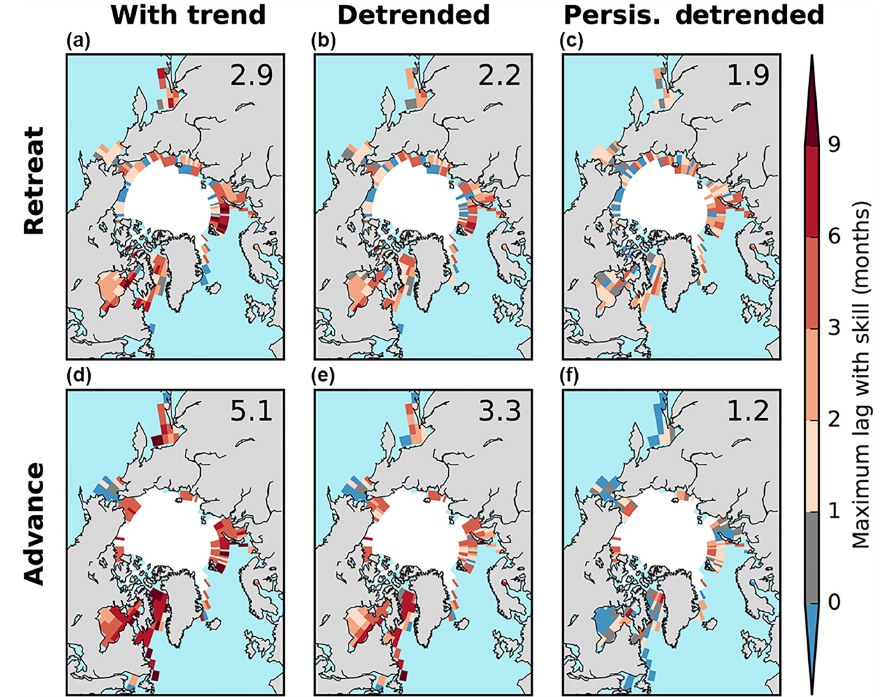
Figure 15. Maximum lead time at which CanSIPS skillfully predicts retreat and advance dates (defined as the calendar date at which sea ice concentration first drops below or exceeds 50%) for total anomalies (first column), detrended anomalies (second column), and a detrended persistence forecast based on persisting the observed initial sea ice concentration anomaly. The numbers in the top right corner of each panel indicate the Arctic average maximum lead time (in months). From Sigmond et al.